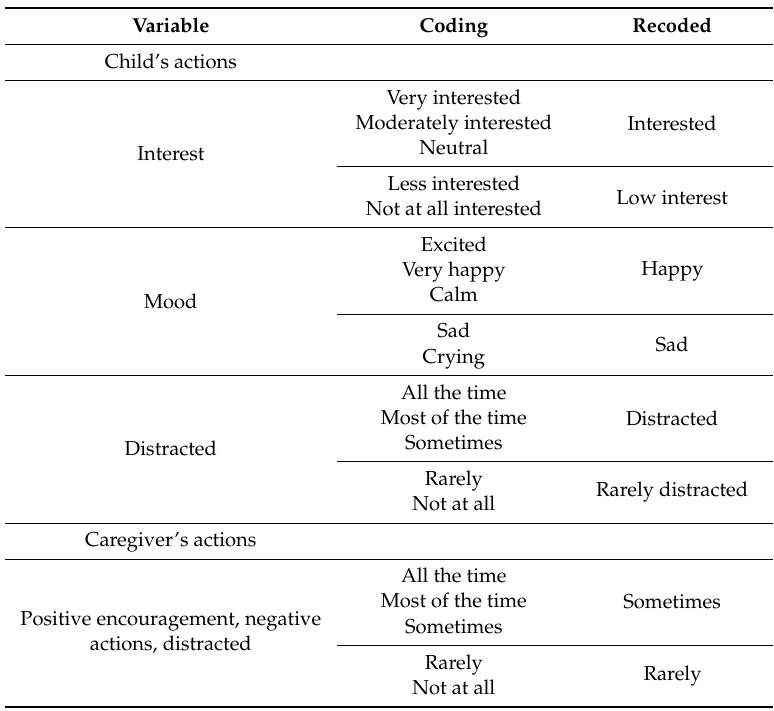
Table 1. Coding and recoding of behaviors during